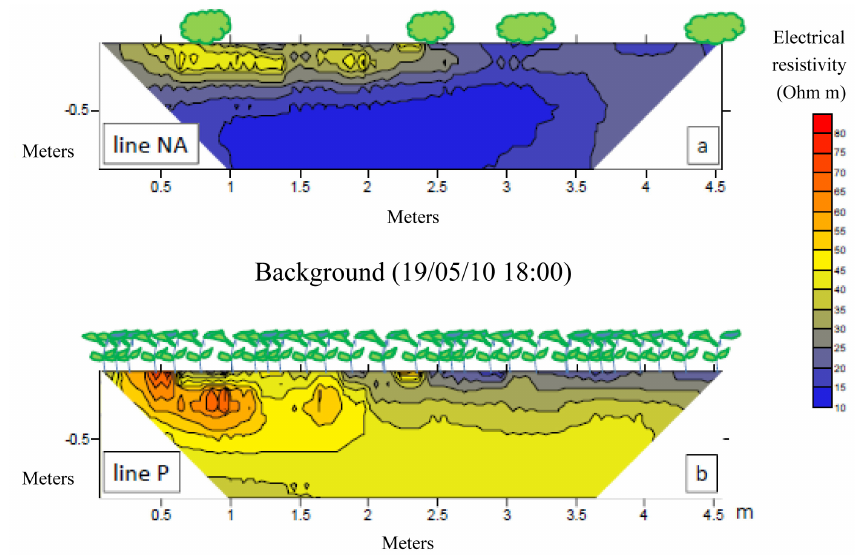
Fig. 5. Background images of the fallow (a) and of the adjacent cultivated (b)